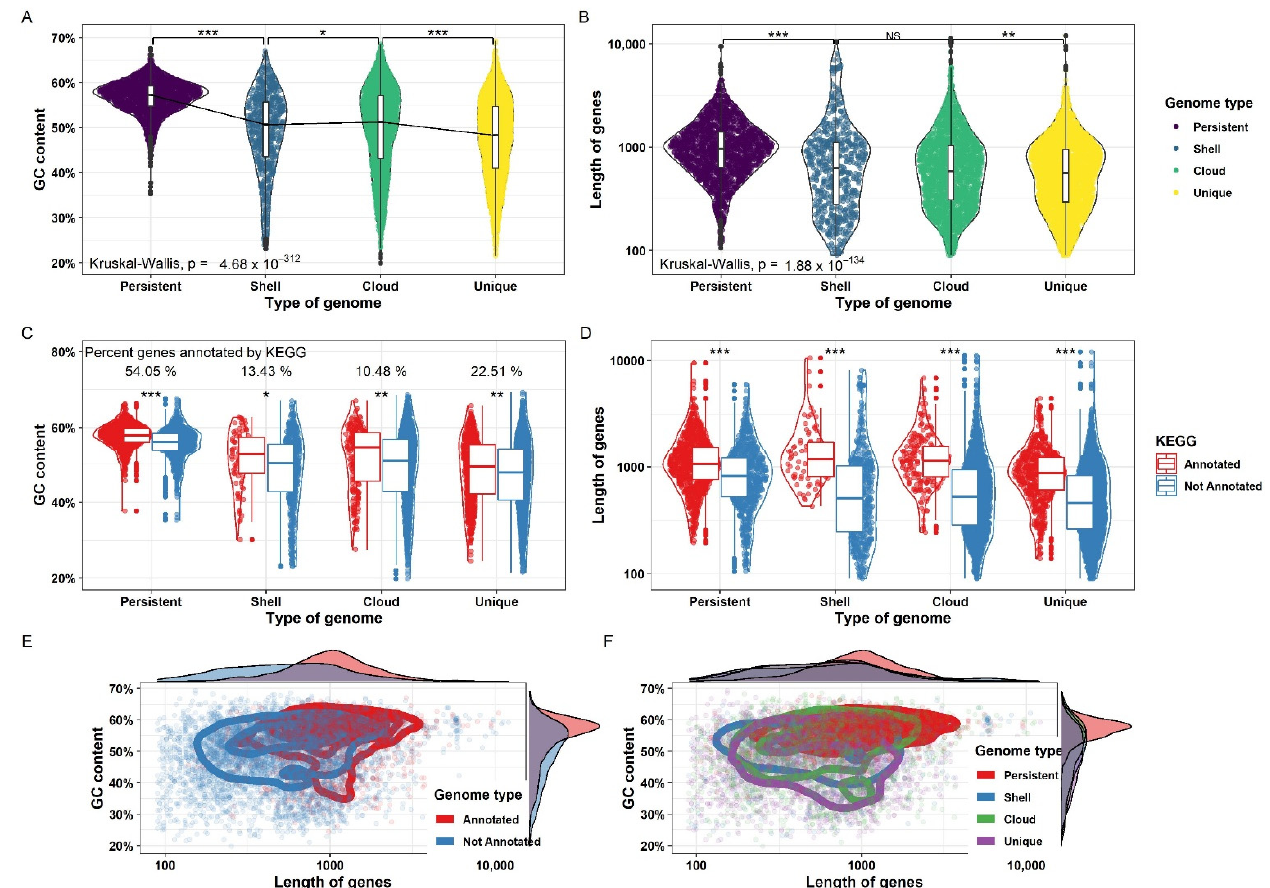
Figure 8. Distribution of GC content and gene length among different sections of the